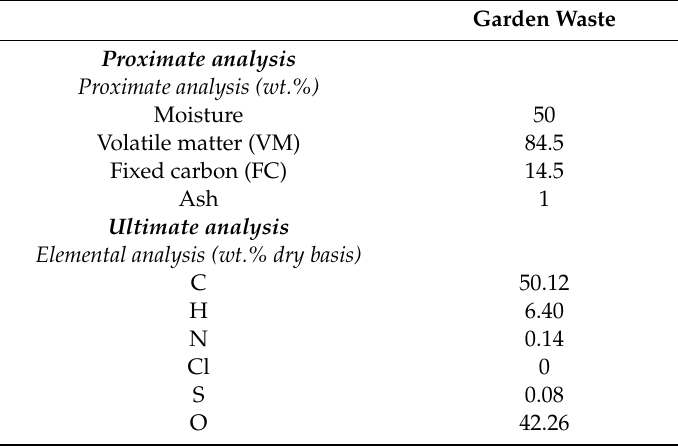
Figure 2. ASPEN Plus flow chart of the system. Table 2. Ultimate and proximate analysis of garden